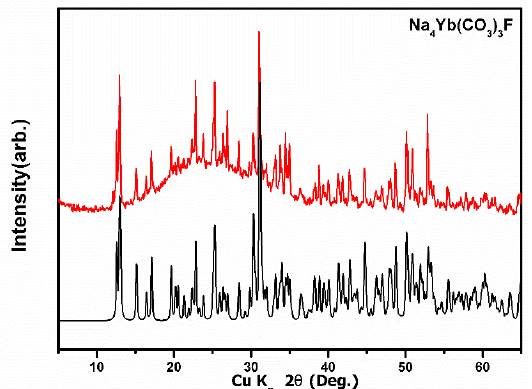
Figure 1. X-ray powder diffraction patterns of Na 4 Yb(CO 3 ) 3 F. The black curves are the calculated ones,